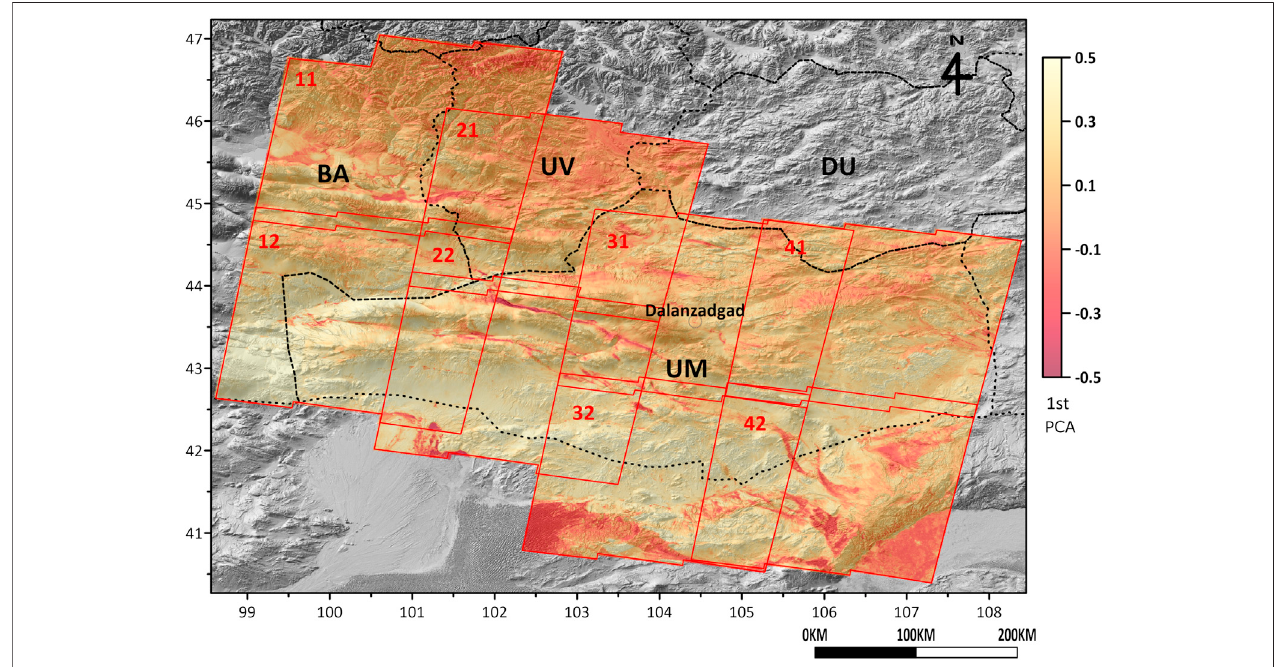
FIGURE 1 | The context of the target area and the InSAR overages analyzed for the mapping of eolian surface erosion together with fi rst PCA PC. Refer to Supplementary Table S1 for the detailed information of each InSAR coverage.